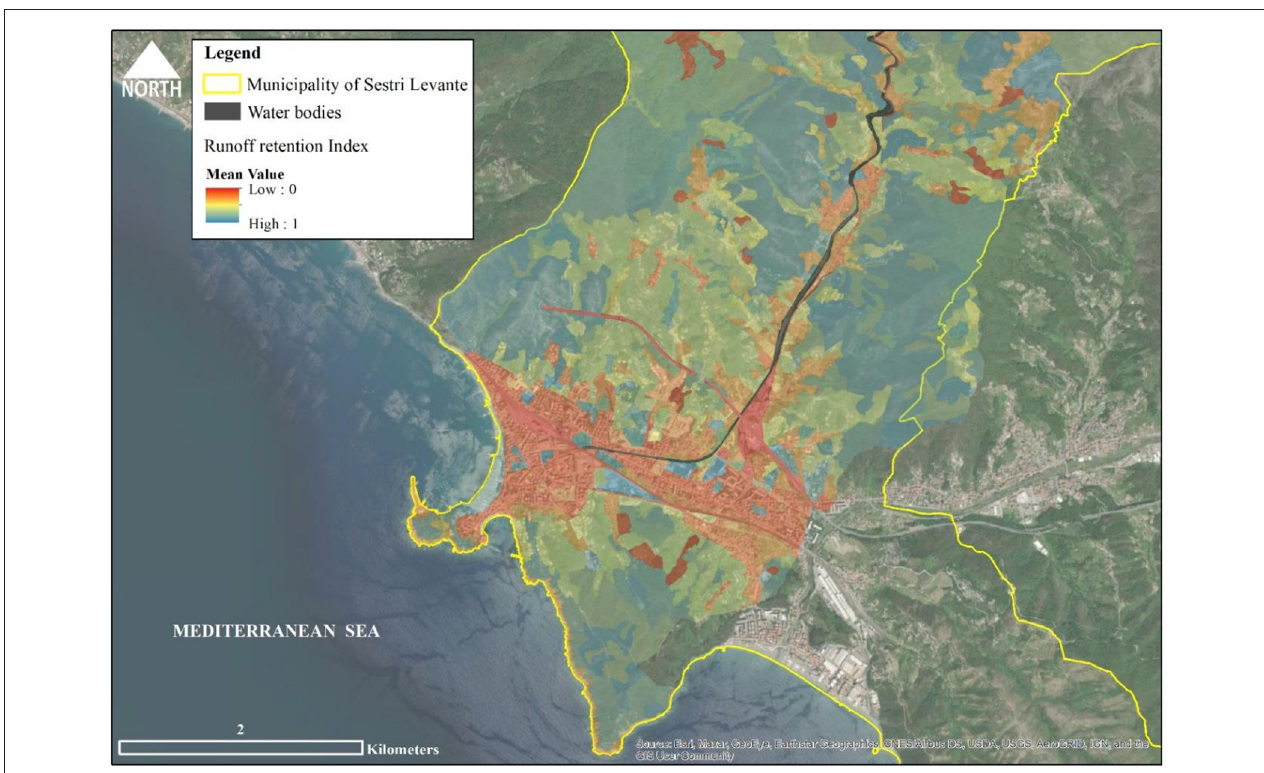
FIGURE 7 | Runoff retention Index per Land use for Sestri Levante (50mm of rainfall) (source: